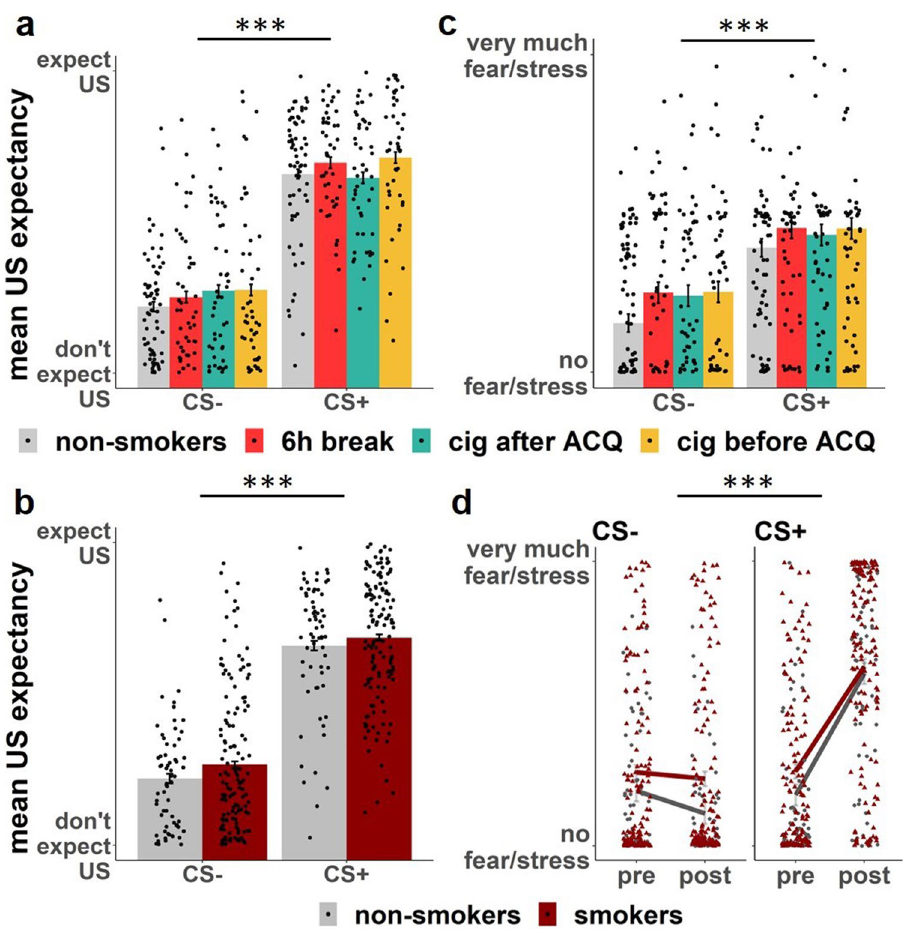
Figure 1. Rating Results Fear acquisition Day 1. Participants rated their US expectancy for every trial and their fear before and after fear acquisition. Individual representations indicate the mean for each subject. ( a ) Day 1 mean US expectancy of each group per stimulus. No group differences were found. ( b ) Day 1 mean US expectancy smokers versus non-smokers. No group differences were found. ( c ) Day 1 mean fear rating of each group. No group differences were found. ( d ) Day 1 fear rating smokers versus non-smokers. Following the colour, grey circles represent non-smokers and red triangles represent smokers. Both smokers and